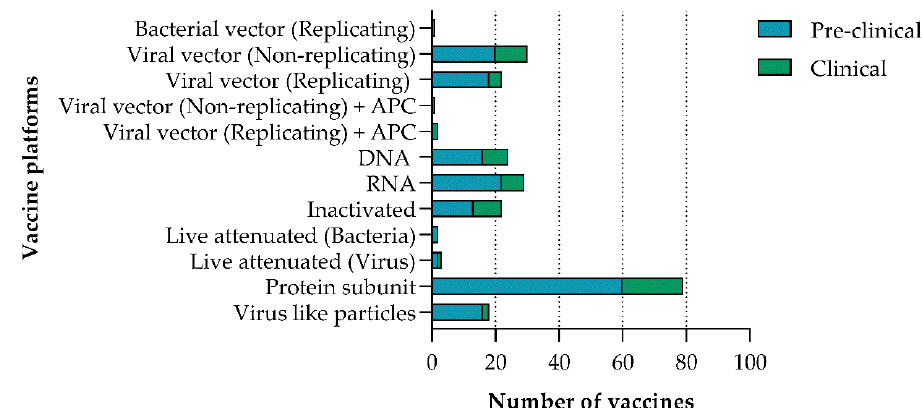
Figure 2. Platforms in use for COVID-19 candidate vaccine development in pre-clinical (blue) and clinical (green) trials [9]. APC: antigen presenting cell; DNA: deoxyribonucleic acid; RNA: ribonucleic acid. (Data figure created by Juanita Mellet.)